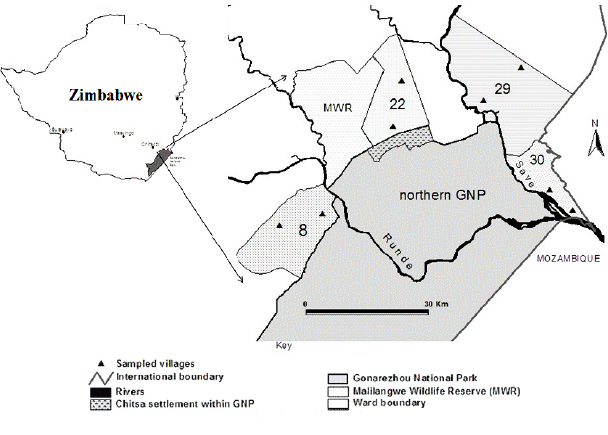
Fig. 1 . Location of the four study communities adjacent to the northern Gonarezhou National Park (GNP),